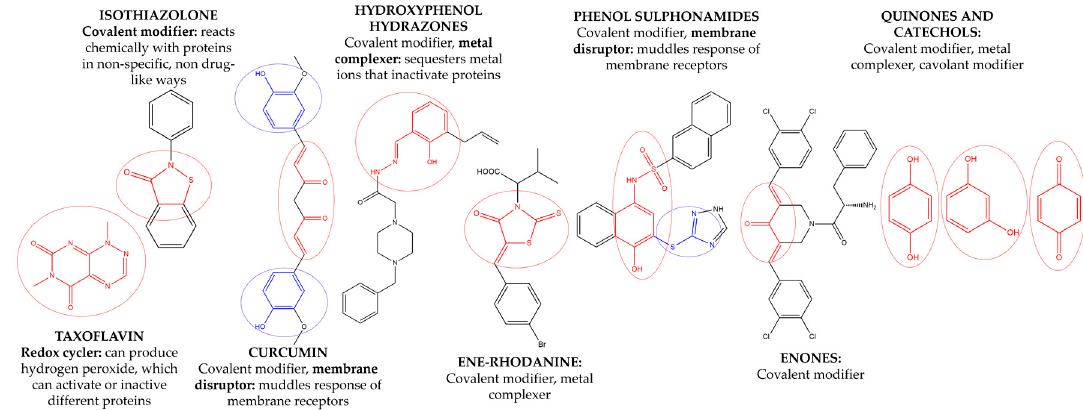
Figure 12. The chemical substructures of PAINS (in blue and red show reactive portions).